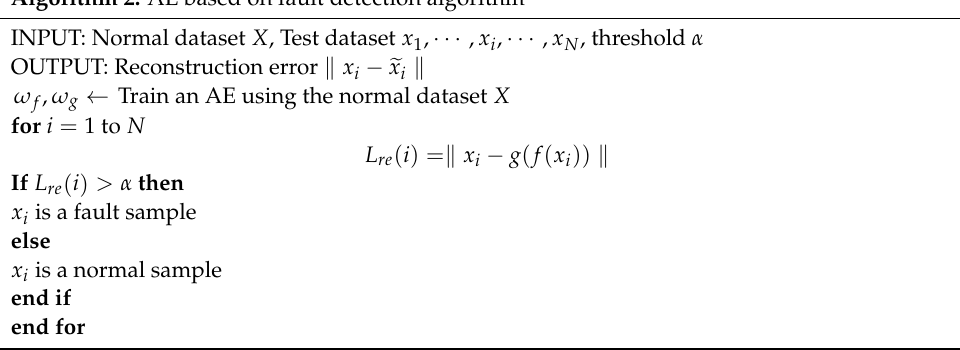
Algorithm 2: AE based on fault detection